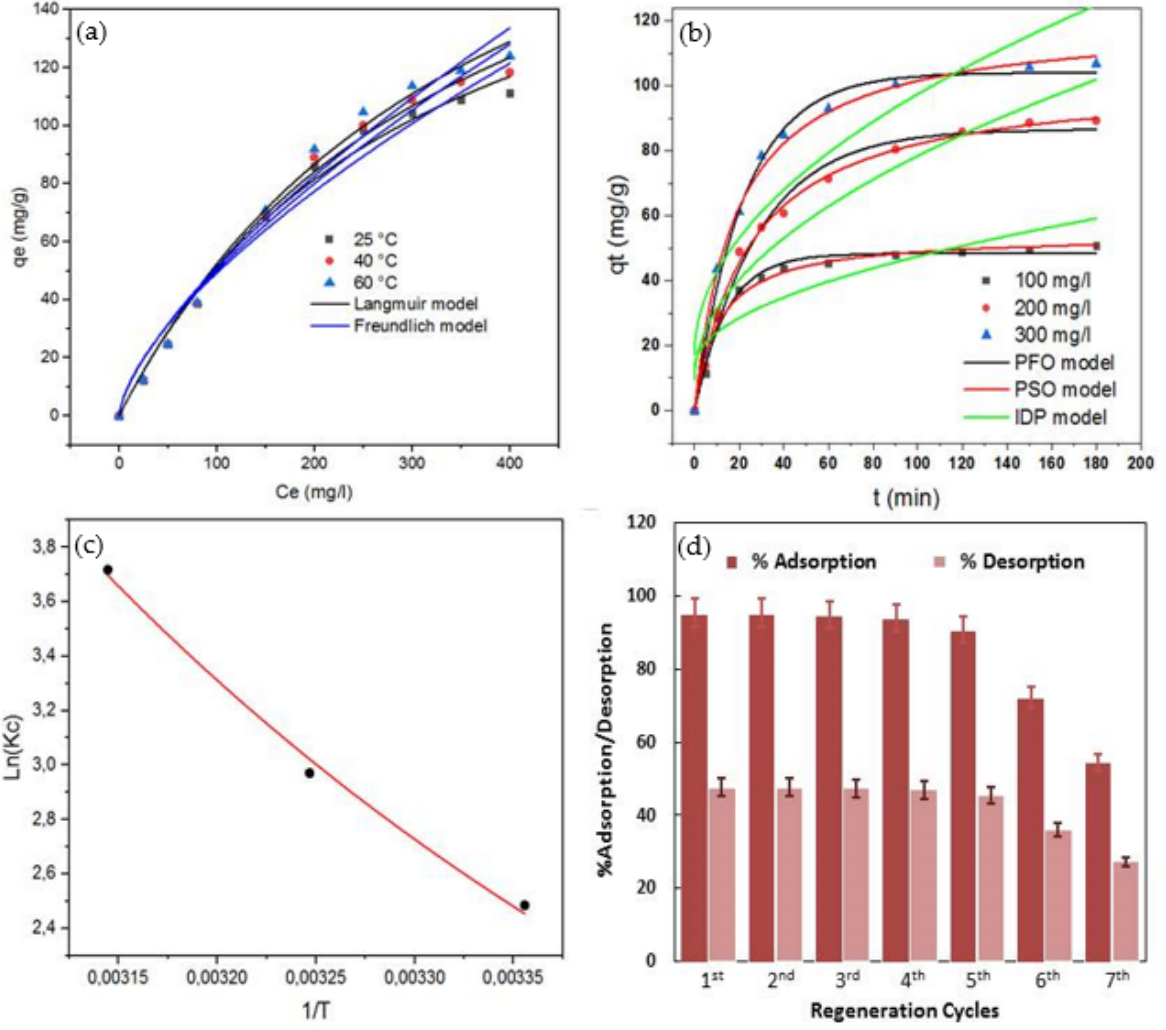
Figure 4. Nonlinear adsorption equilibrium isotherm models ( a ), and adsorption kinetic models ( b ) for MO adsorption on CHt@MgO; Van’t Hoff plot ( c ) and CHt@MgO regeneration plot ( d ).